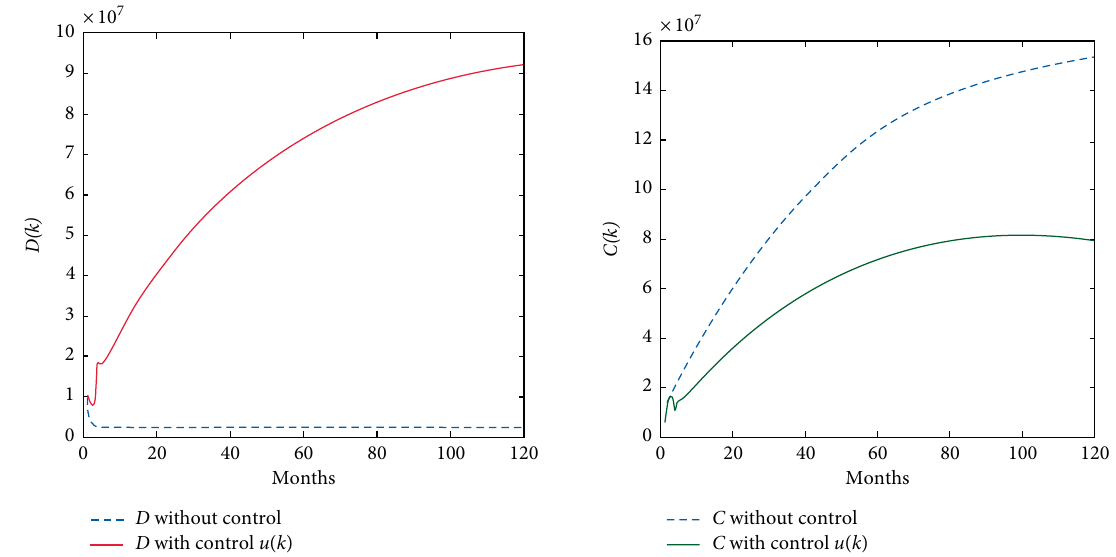
Figure 3: The evolution of the number of diabetics with and without complications with control 𝑢